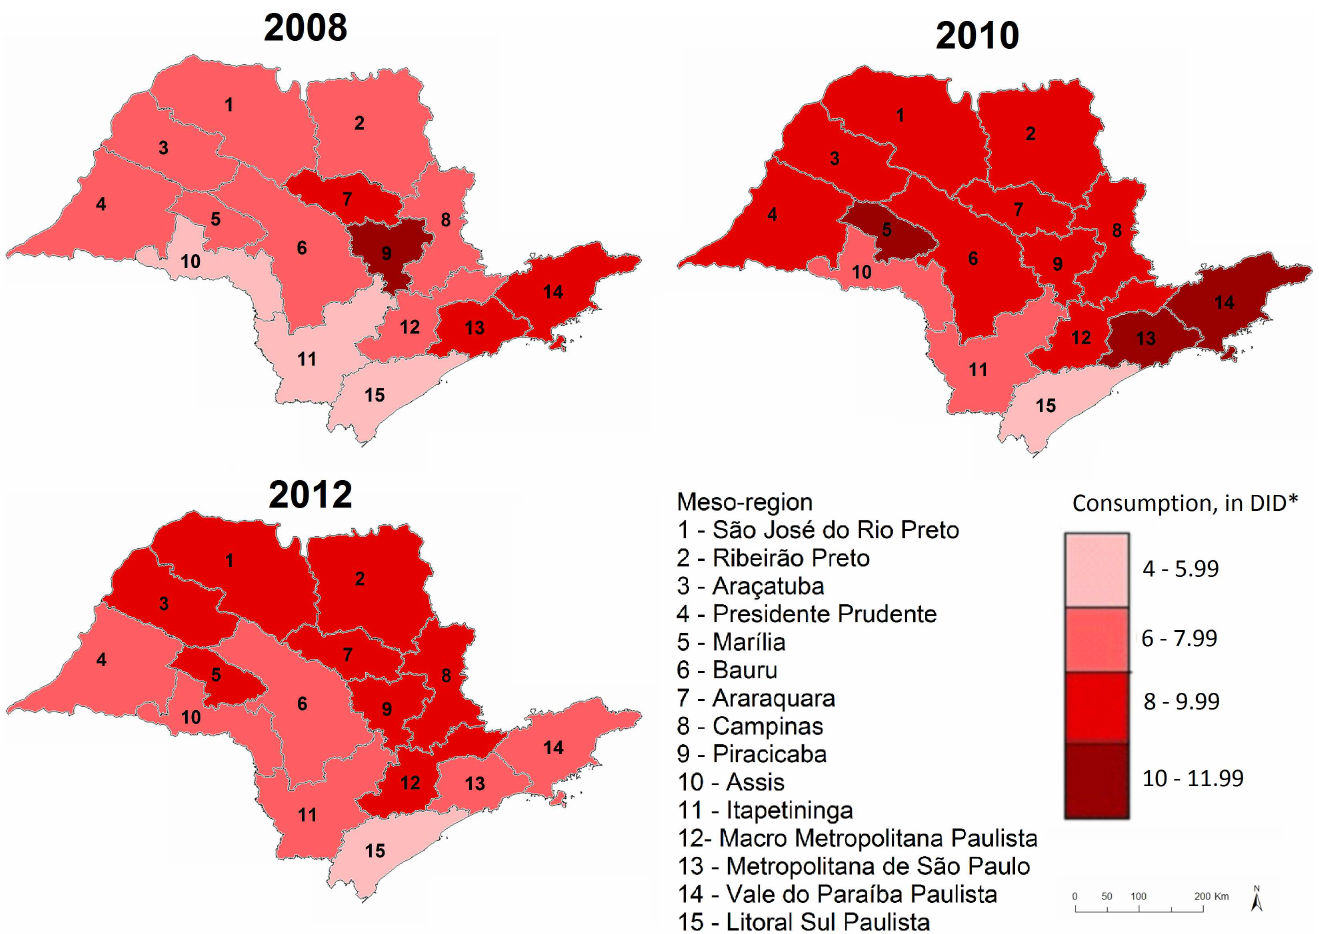
Fig 2. Oral antibiotic consumption by meso-region in 2008, 2010 and 2012. * DID: defineddaily doses per 1,000 inhabitantsper day.